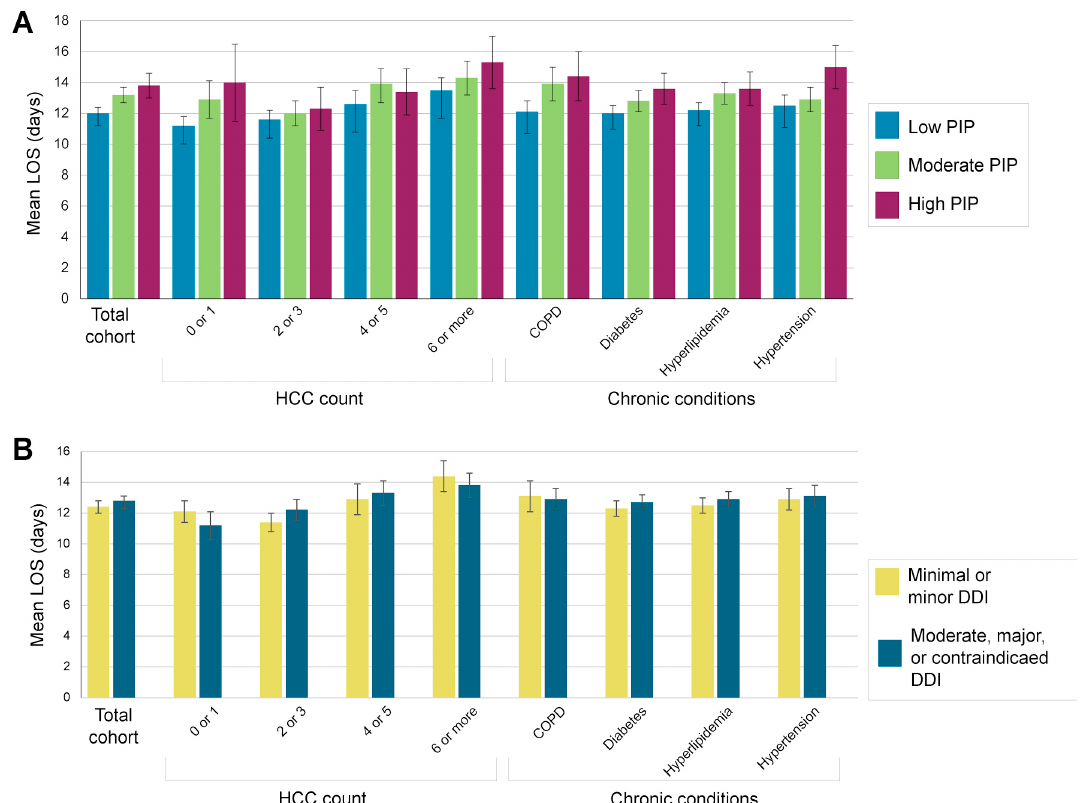
Figure 2. Length of stay by pharmacogenomic risk among Medicare Advantage members hospitalized with COVID-19. Average length of stay (LOS) in days among the entire cohort and subpopulations stratified by HCC count or chronic conditions was compared by ( A ) pharmacogenomic interaction probability (PIP) and ( B ) drug–drug interaction (DDI). Error bars show 95% confidence intervals. PIP: pharmacogenetic interaction probability; HCC: hierarchical condition categories; COPD: chronic obstructive pulmonary disease.